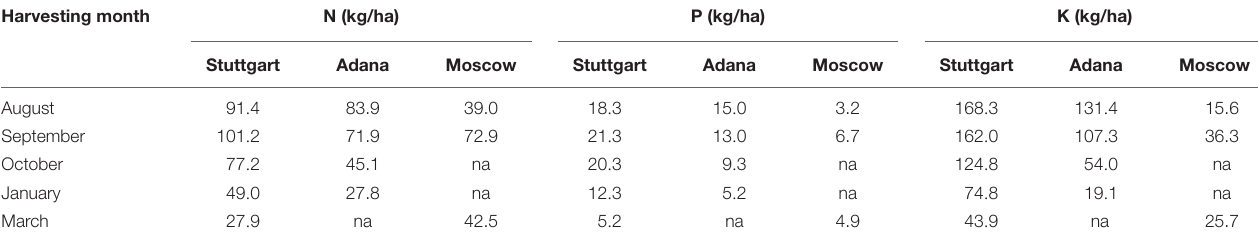
TABLE 4 | Mean nutrient offtake (N, P, K) at each site and harvesting month for all five genotypes. Harvesting month N (kg/ha) P (kg/ha) K (kg/ha)